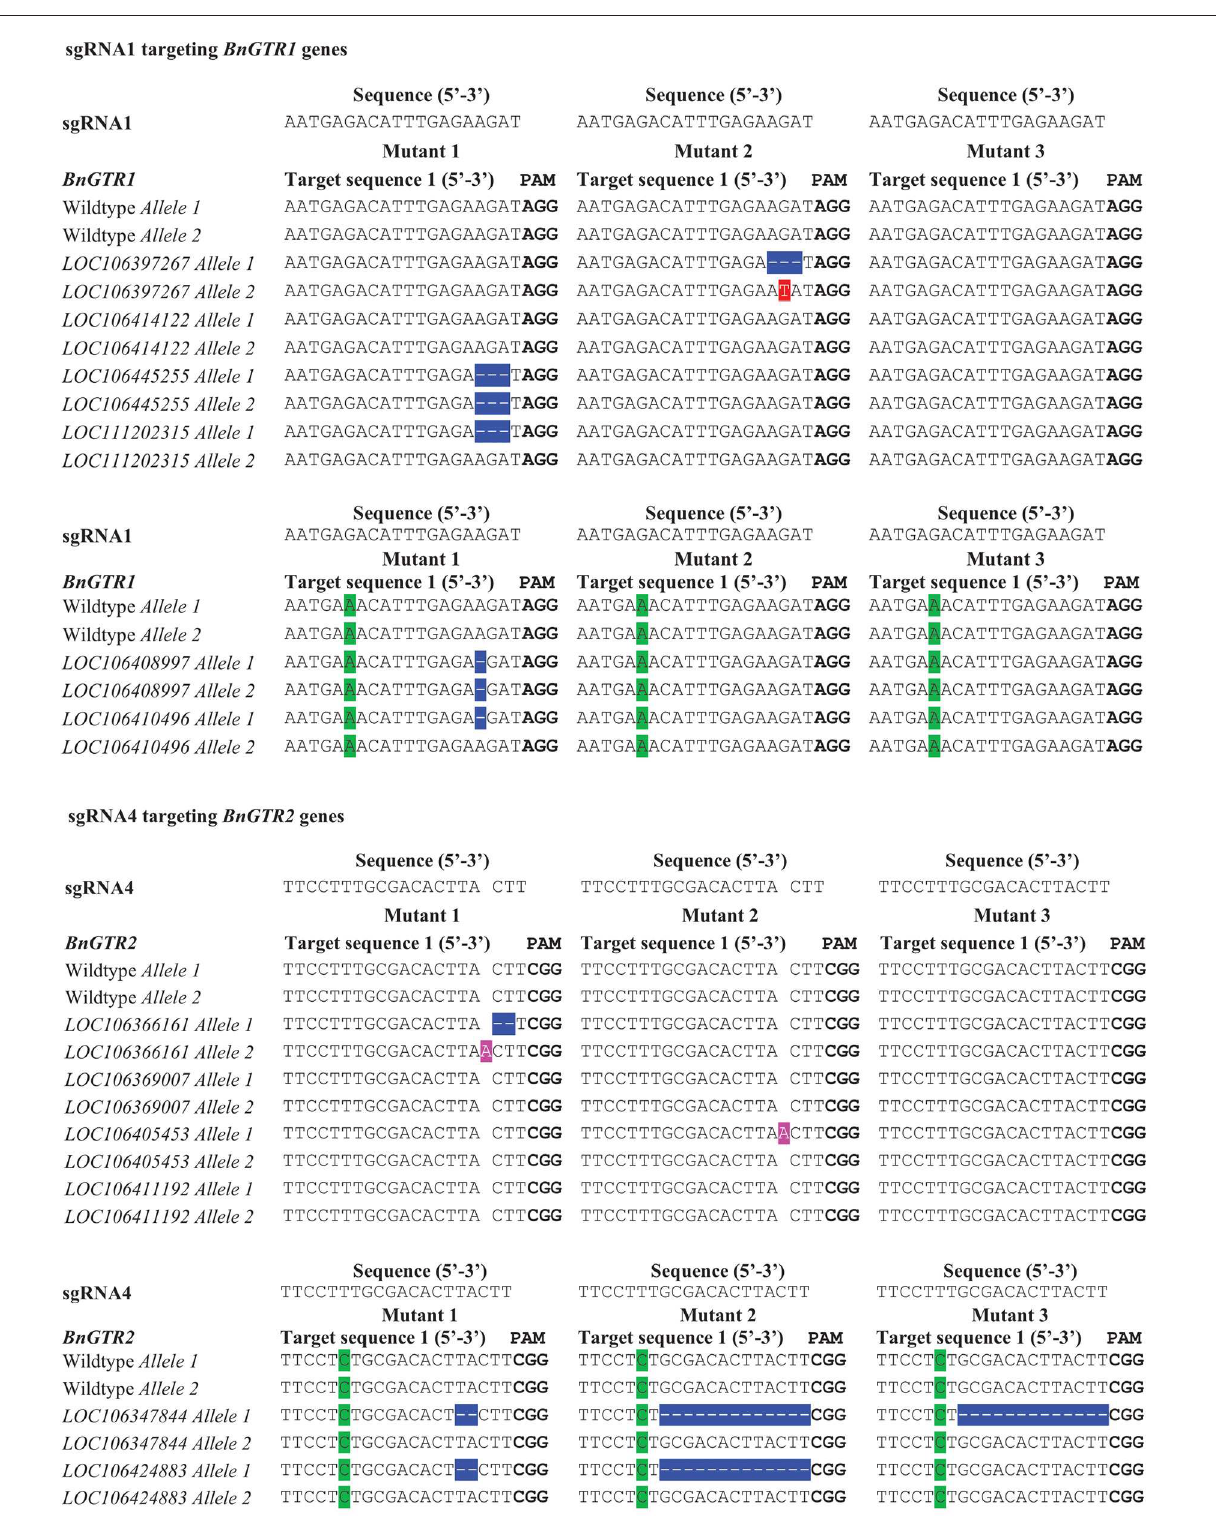
Frontiers in Plant Science |